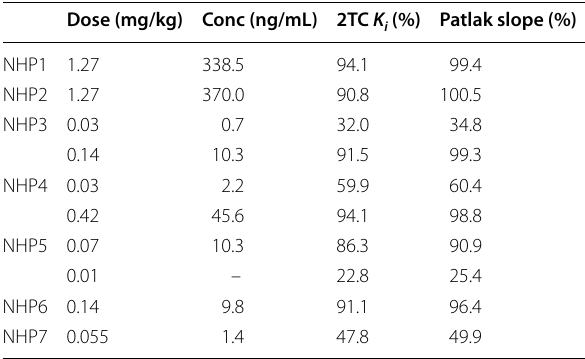
Table 1 Dose of PF-06818883, plasma concentration of PF-06807893, and MAGL